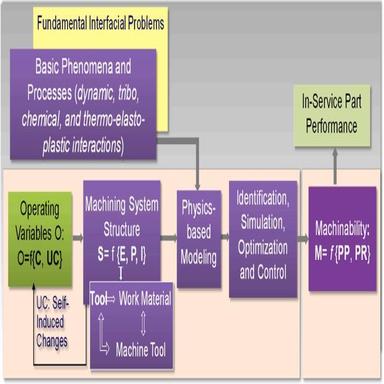
An integrated system approach to 'machining performance'.